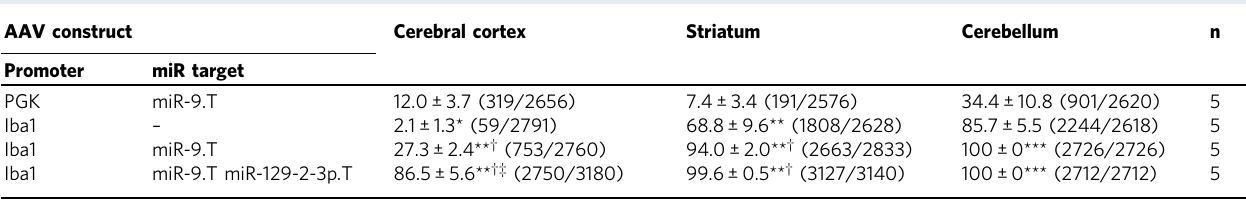
transcriptional regulatory element. Table 1 Microglia speci fi city of AAV vectors in different brain